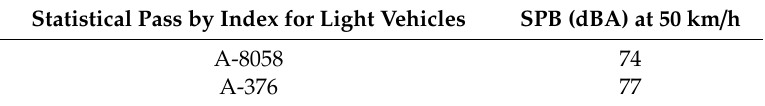
Table 2. SPB values measured at both test tracks at the beginning of the project.